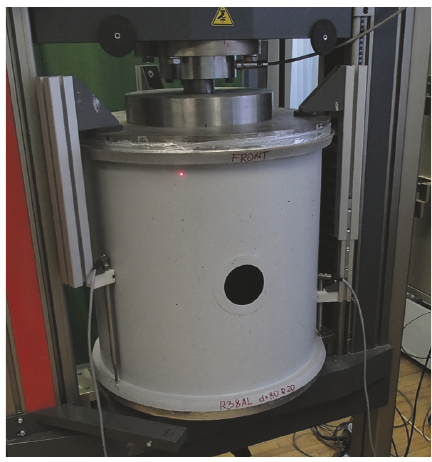
Figure 5: Experimental test